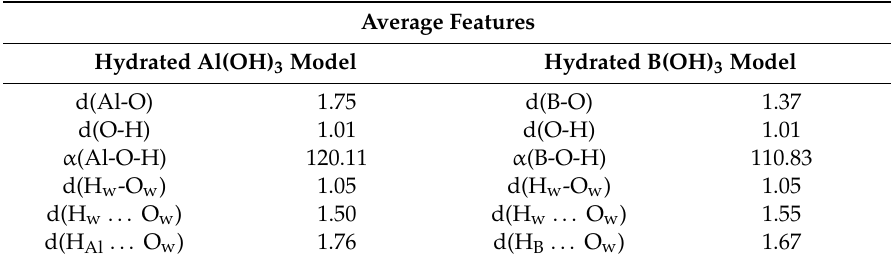
Table 4. Interatomic distances of hydrated Al(OH) 3 and B(OH) 3 models (distances in Å and angles in ◦